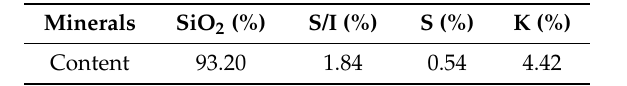
Table 1. Characterization of the minerals in the samples.